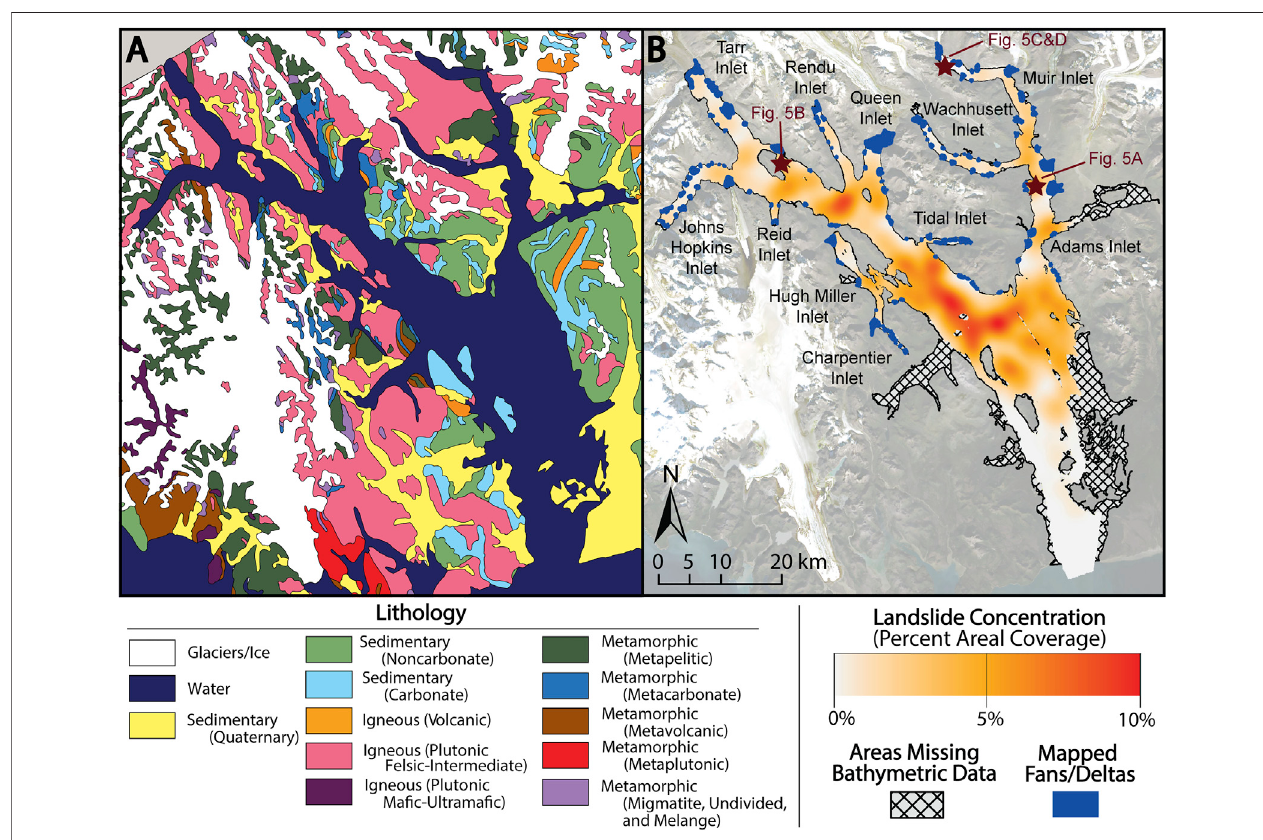
FIGURE 3 | (A) Regional lithologic map of Glacier Bay and surrounding area modi fi ed from Brew (2008). Geologic units are shown without ages and lumped togetheraccordingtogenerallithologicproperties. (B) RawsubmarinelandslideconcentrationmapforGlacierBay,expressedasapercentageoftotalareacalculatedin amovingwindowwitha3 kmradius.Deltasandfansthatextendintothebathymetryaremappedfrombathymetryusedinthisstudy,subaerial5 mIFSAR,andLandsat and DigitalGlobe satellite imagery. Background imagery is from 2018 Landsat data. Major inlets are labeled for reference to the text. Stars show the locations of areas depicted in Figure 5